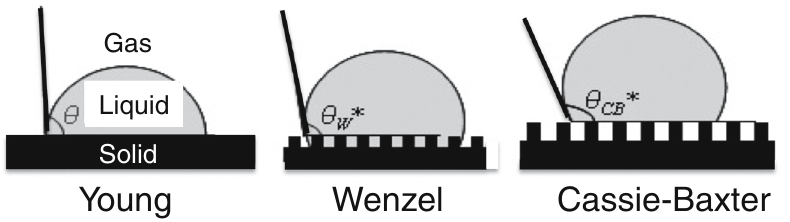
Figure 9: Schematic representations of Young, Wenzel, and Cassie – Baxter states of liquids on solids. θ is the apparent contact angle corresponding to the stable equilibrium